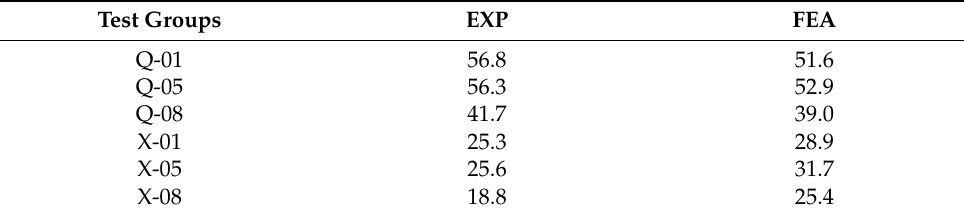
Table 4. Comparison of P ult between Experiment results and FE results.